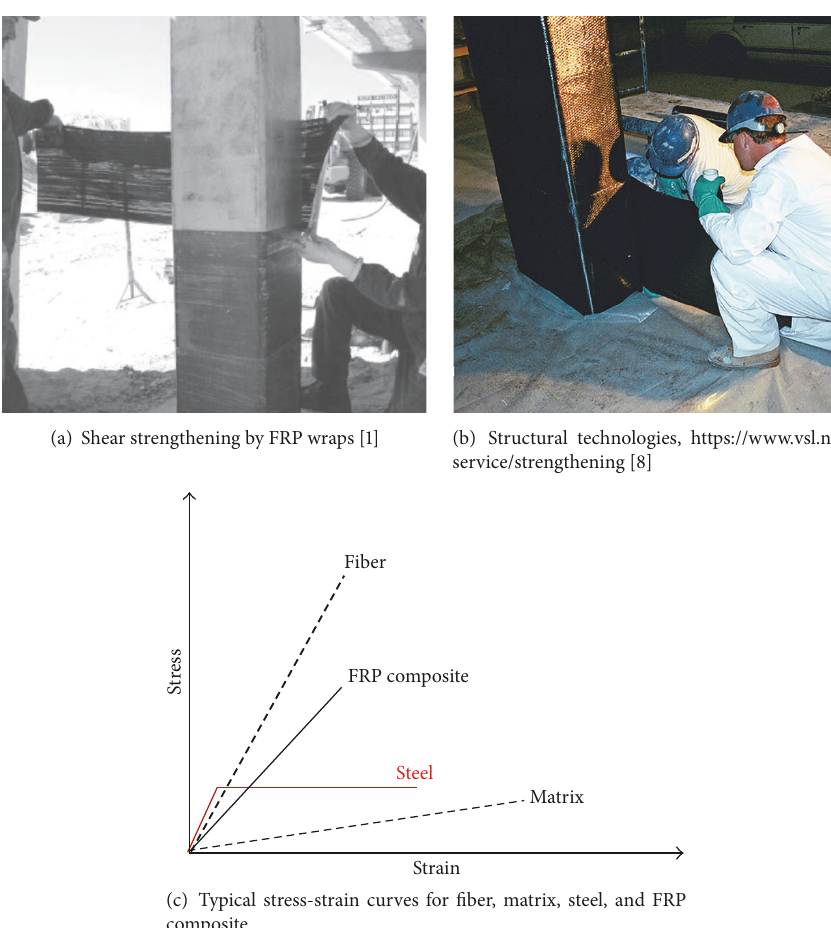
Figure 1: Application methods and properties of FRP